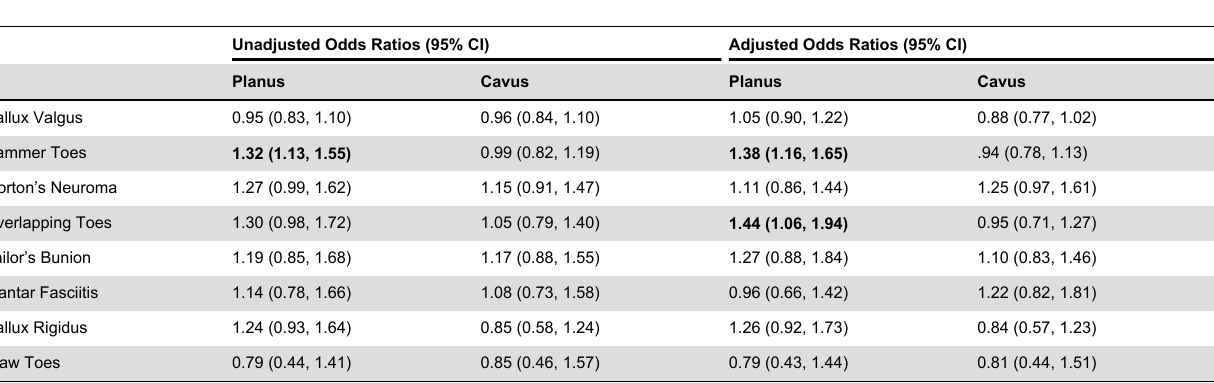
Table 2. Unadjusted and adjusted * odds ratios and 95% confidence intervals (CI) for relation of foot disorders to foot posture as defined by modified arch index